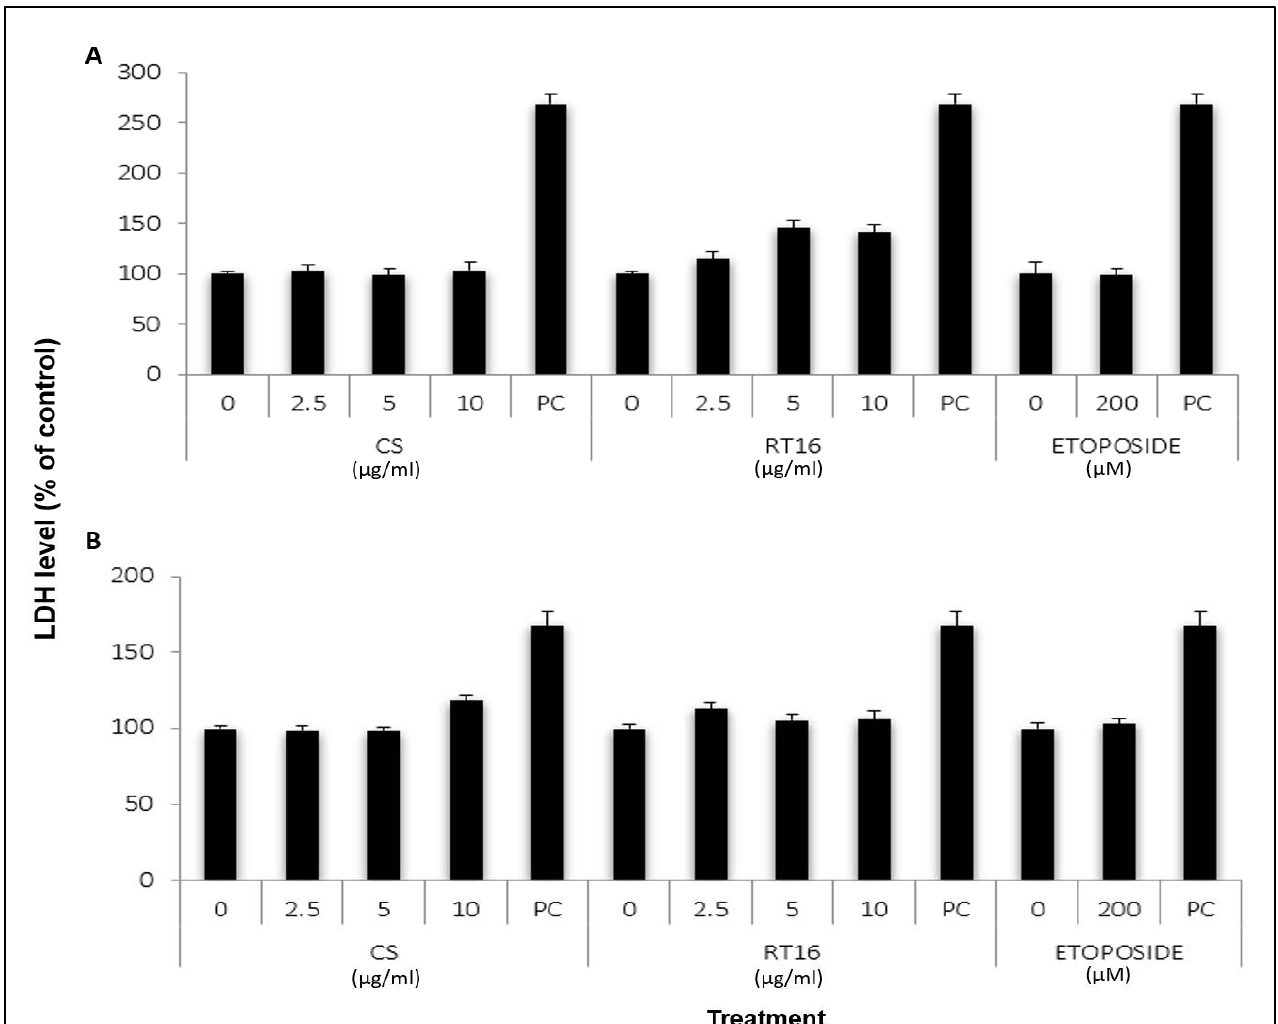
Figure 4. The effect of RT16, CS extract, and etoposide on LDH levels of HPAF-II ( A ) and PL45 ( B ) cells. The cells were seeded into a 96-well plate (10 4 cells/mL) for 24 h and then were treated with various concentrations of RT16, CS extract, or 200 μ M etoposide and incubated for 24 h. At the end of the treatment, LDH leakage was measured, as described under “Material and Methods”. Results presented an average of three independent experiments, three repeats each (mean ± SEM), and expressed as percentages of the control (non-treated cells). All treatments were found significantly different than the positive control (Triton X-100) which was detected by two-way ANOVA ( p < 0.001).